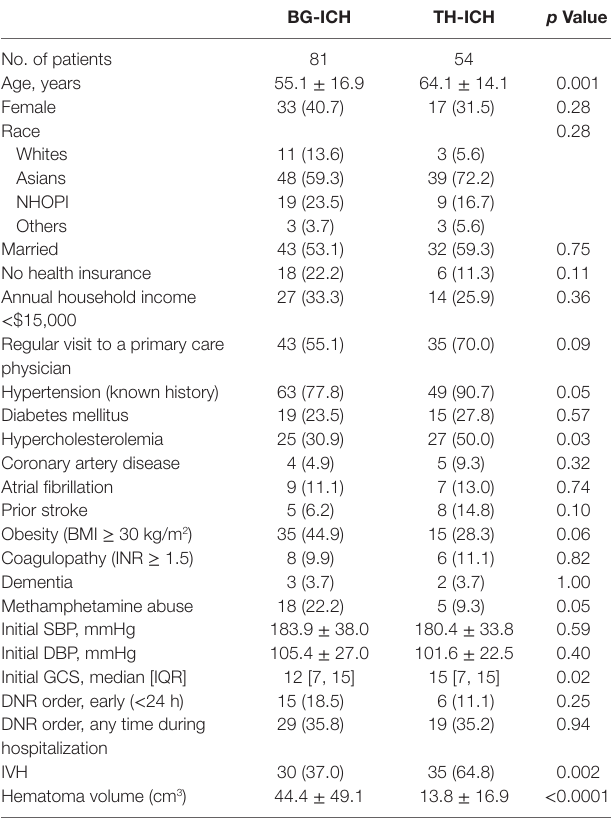
taBLe 1 | Clinical characteristics of basal ganglia and TH-ICH